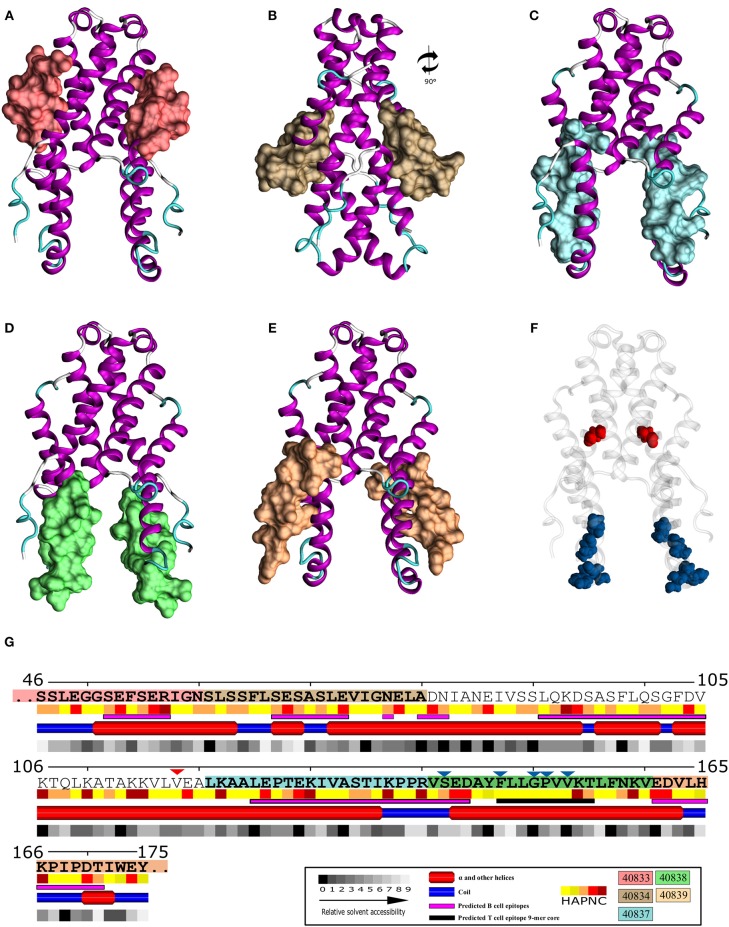
PvCeltos protein structure model. Location of the studied peptides in PvCelTOS dimer structure (Jimah et al., 2016): (A) Peptide 40833 (red), (B) Peptide 40834 (brown), (C) Peptide 40837 (light blue), (D) Peptide 40838 (green), (E) Peptide 40839 (orange). (F) Positions submitted to selective pressure; positive selected positions: 118 (red) and negative selected positions 142, 147, 150, 151, and 153 (blue). (G) Secondary structure representation, including relative solvent accessibility (0-completely buried, 9-fully exposed) and physical-chemical aa profile (H-hydrophobic: A,C,F,G,I,L,M,V, A-amphipathic: H,W,Y, P-polar: N,S,Q,T, and N/C-charged: D,E-neg; R,K-pos). Peptide sequences are showed in bold; positions submitted to positive selection pressure are indicated by red triangles and negatively selection ones by blue triangles. Predicted B- (purple bar) and T-cell epitopes (black bar) are also indicated.